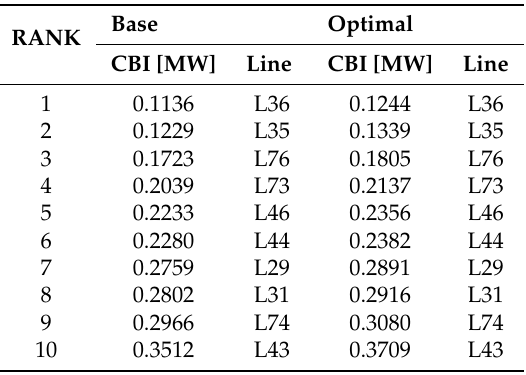
Figure 10. IEEE 57-Line power flow for T32: 12–24. Table 7. Ten critical lines considering CBI ranking for T32: